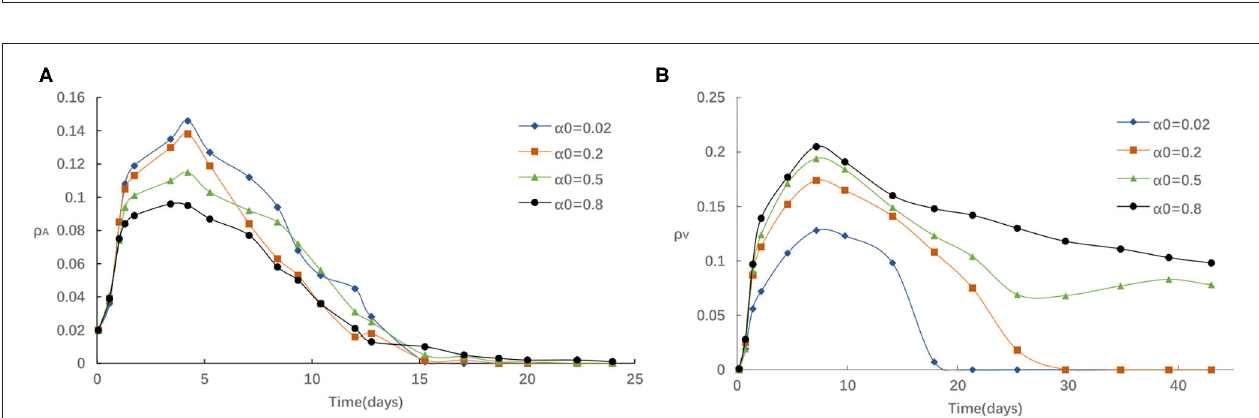
FIGURE 4 | (A) The fraction of infected for different α 0 with η = 0.05, α = 0.3, δ = 0.1. (B) The fraction of vaccinated for different α 0 with η = 0.05, α = 0.3, δ = 0.1.